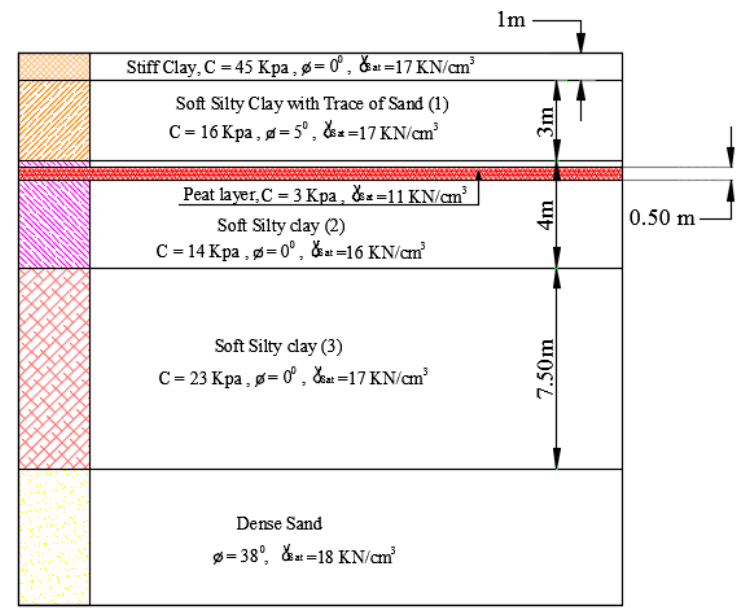
Figure 6. Stratification of slope soil (Al-Ashaal et al. 1998) [42].